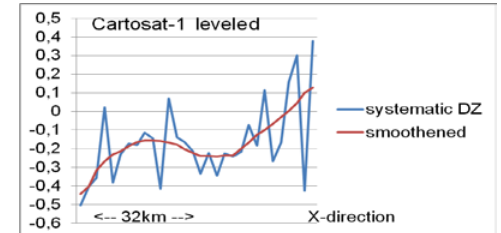
Fig. 19. Systematic height errors in X-direction, Warsaw, leveled Cartosat-1 DSM against reference DTM